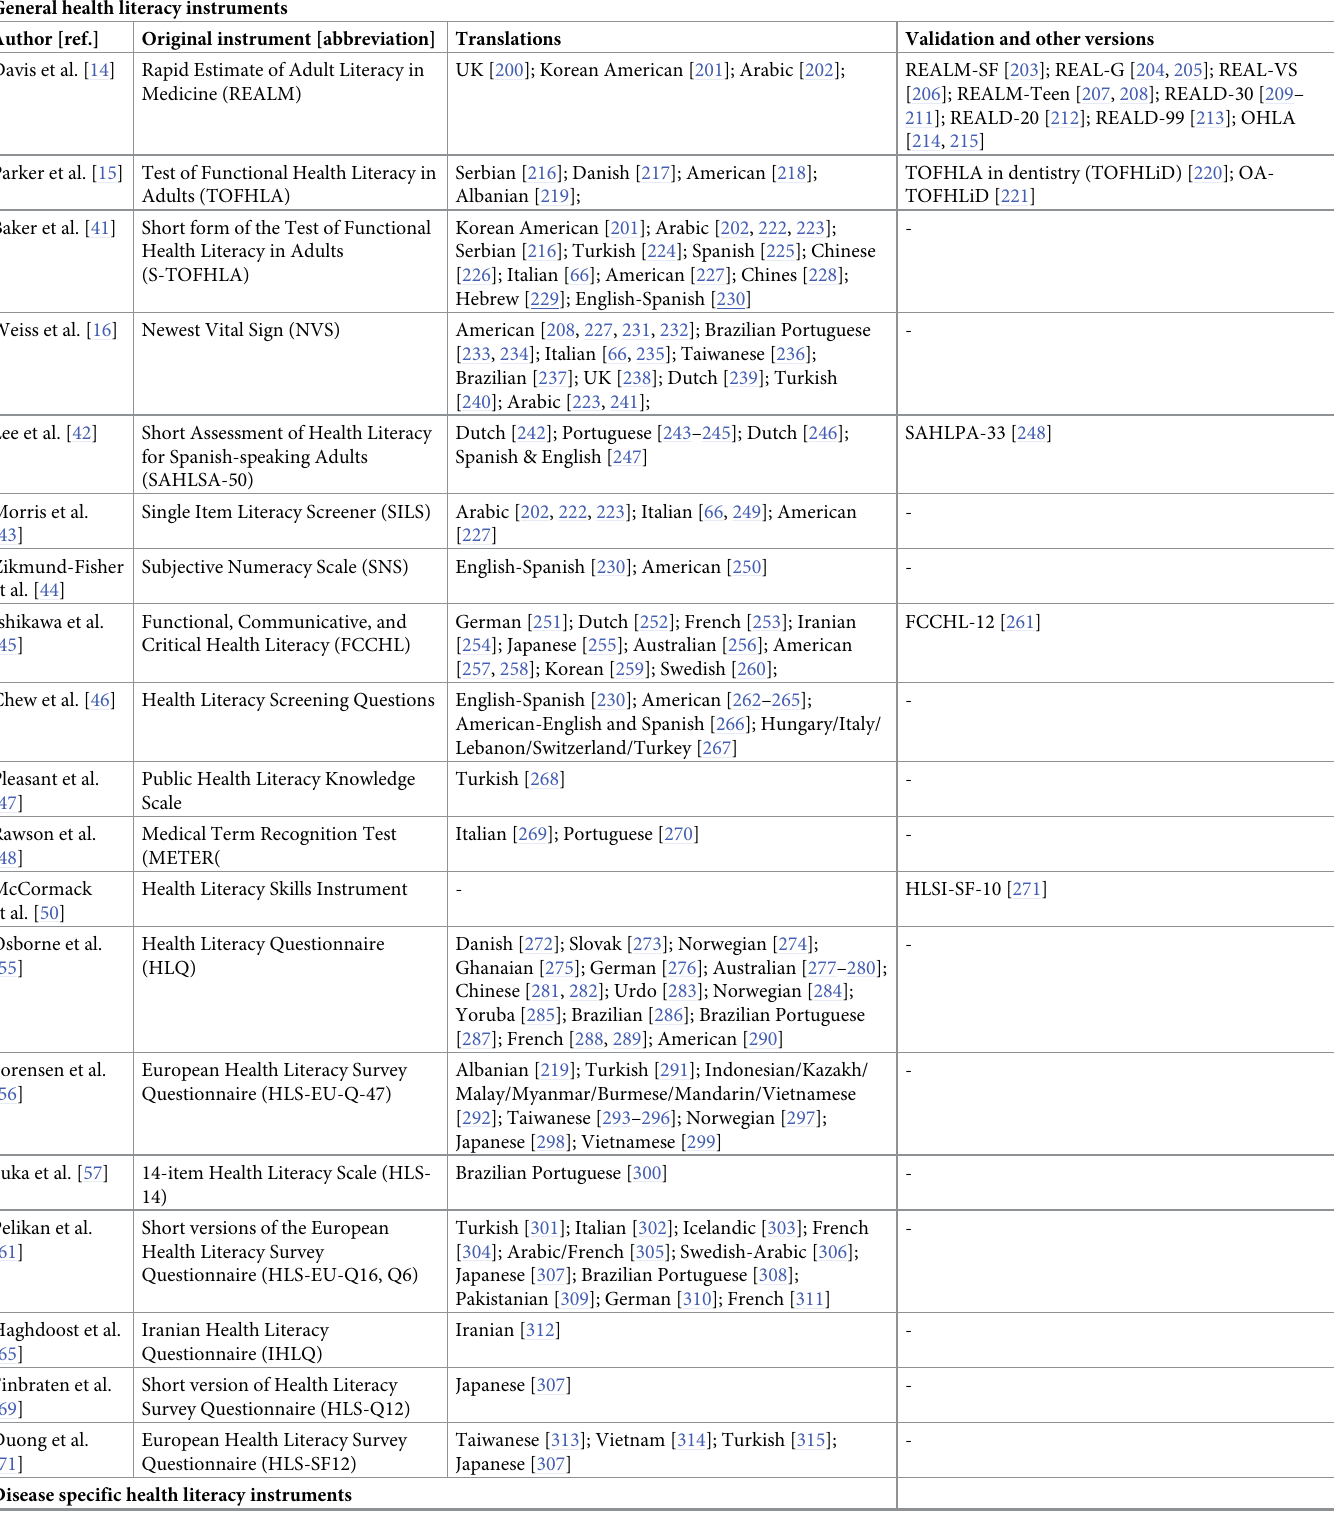
Table 7. The original health literacy instruments and the existing translations and validation versions (1993–2021). General health literacy